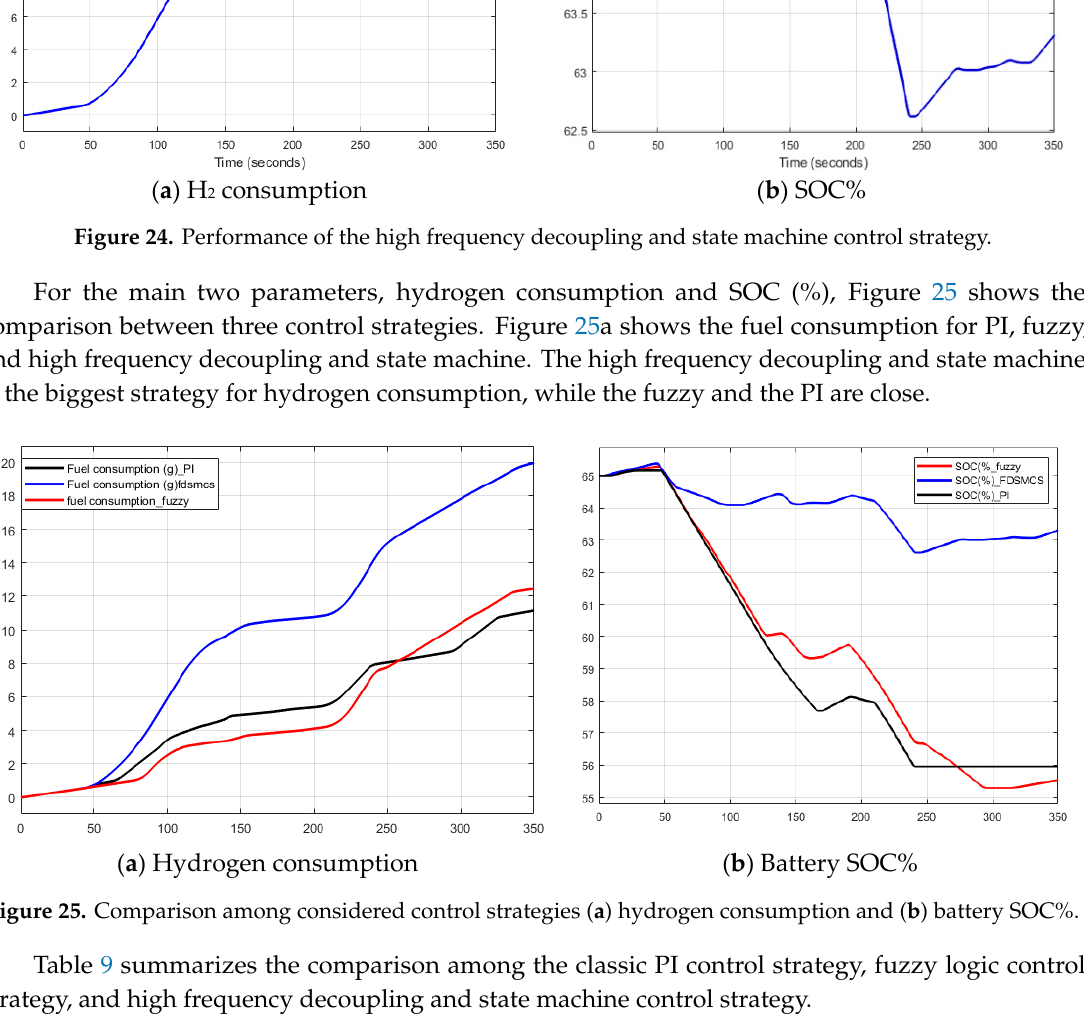
Table 9. Comparison among considered control strategies.